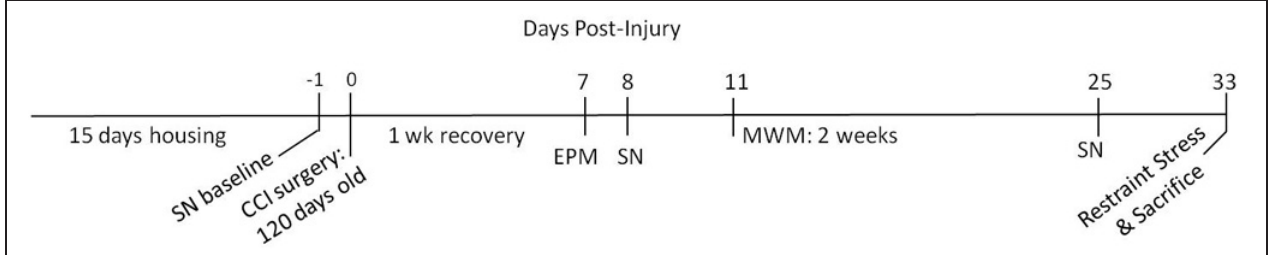
FIGURE 1 | Experimental timeline. The experiment consisted of 15 days of housing (either enriched or standard) followed by controlled cortical impact (CCI) surgery. After 1weekofrecovery, thefollowing behavioral testswereconducted: sensory neglect (SN),elevated plusmaze(EPM),andMorris watermaze(MWM).